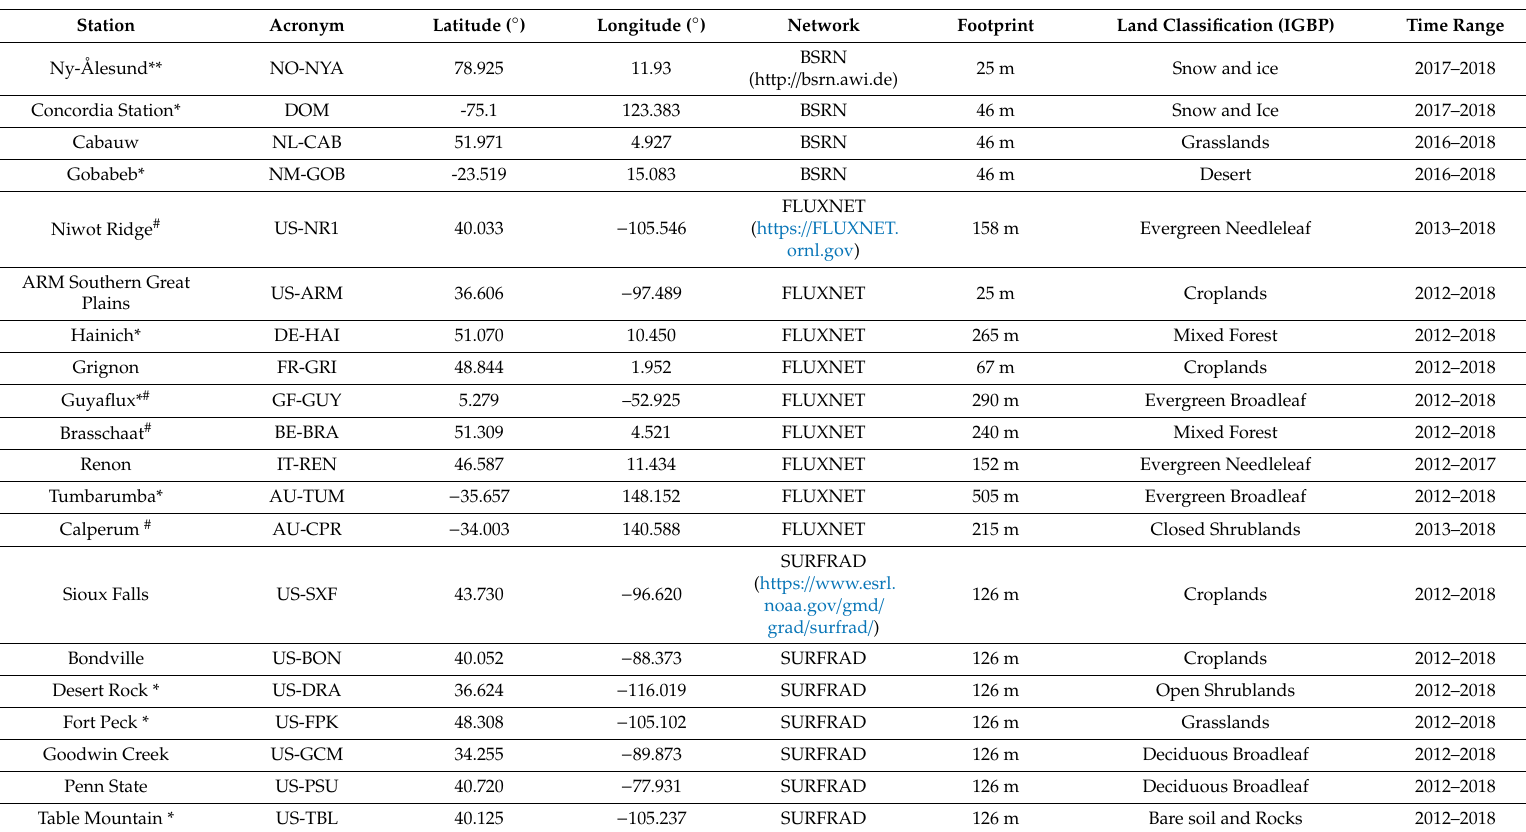
Table 1. List of tower sites with key characteristics: acronyms, geographical coordinates, networks, footprints and land cover types defined by International Geosphere-Biosphere Programme